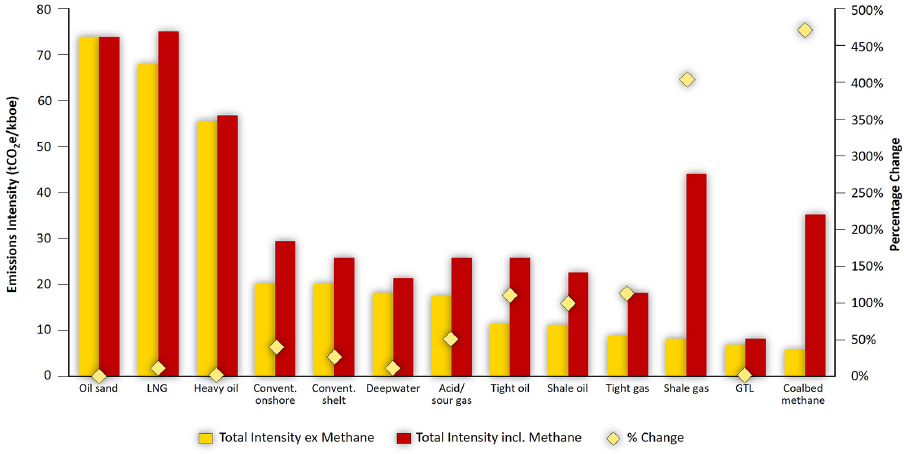
Fig. 6. – Average upstream emissions intensity for different types of oil and gas resource (Source: Wood Mackenzie,